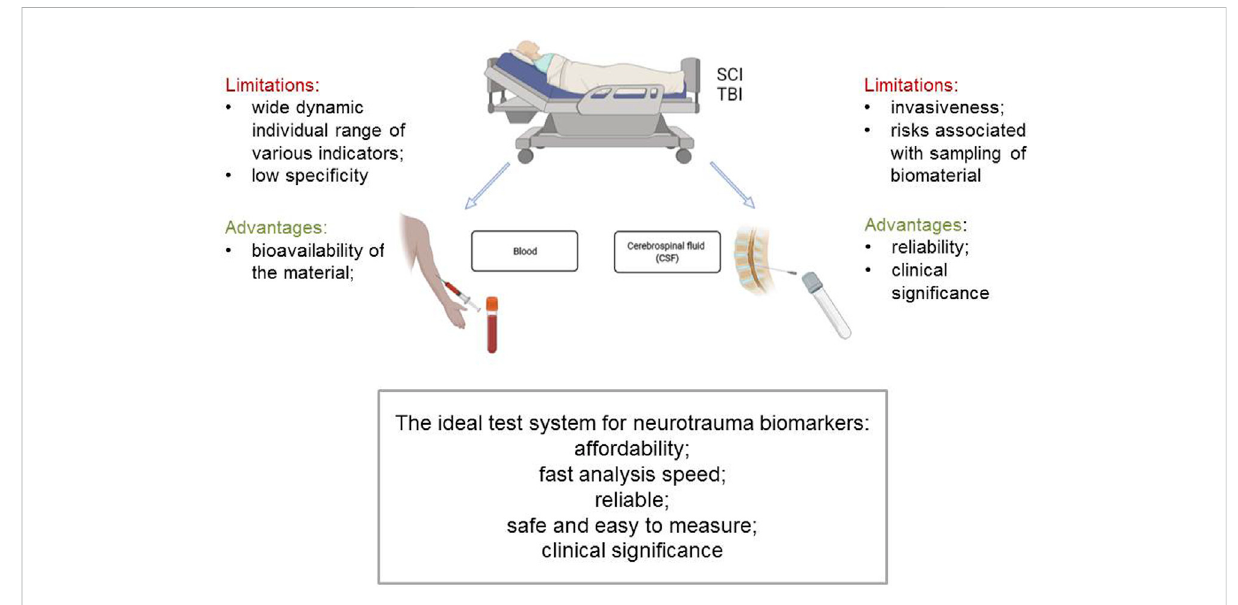
FIGURE 1 Possibilities of using blood and cerebrospinal fl uid as biomarkers of